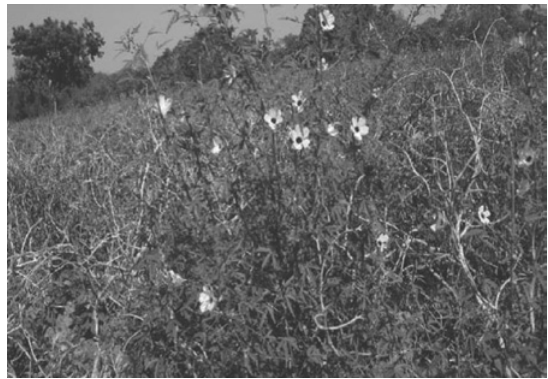
Figure 10: Roselle fiber [4].